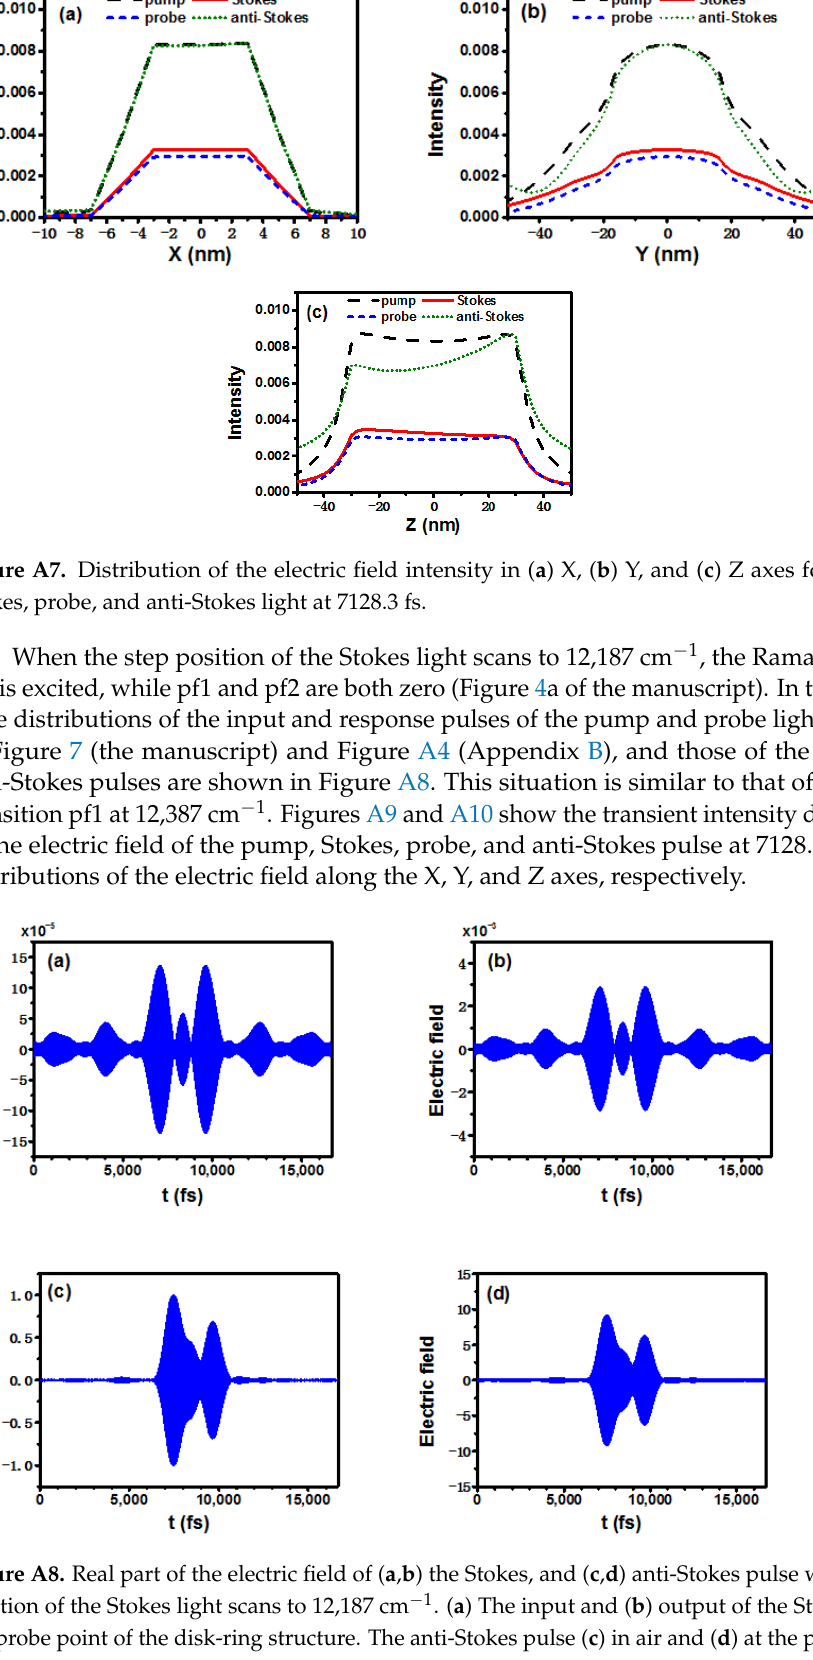
Figure A6. Transient distributions of the electric field of ( a ) pump, ( b ) Stokes, ( c ) probe, ( d ) anti- Stokes light, and ( e ) corresponding SECARS map at 7128.3 fs. The white box in ( e ) is an enlarged view of the area with 60 nm × 60 nm in the center of the disk-ring structure.